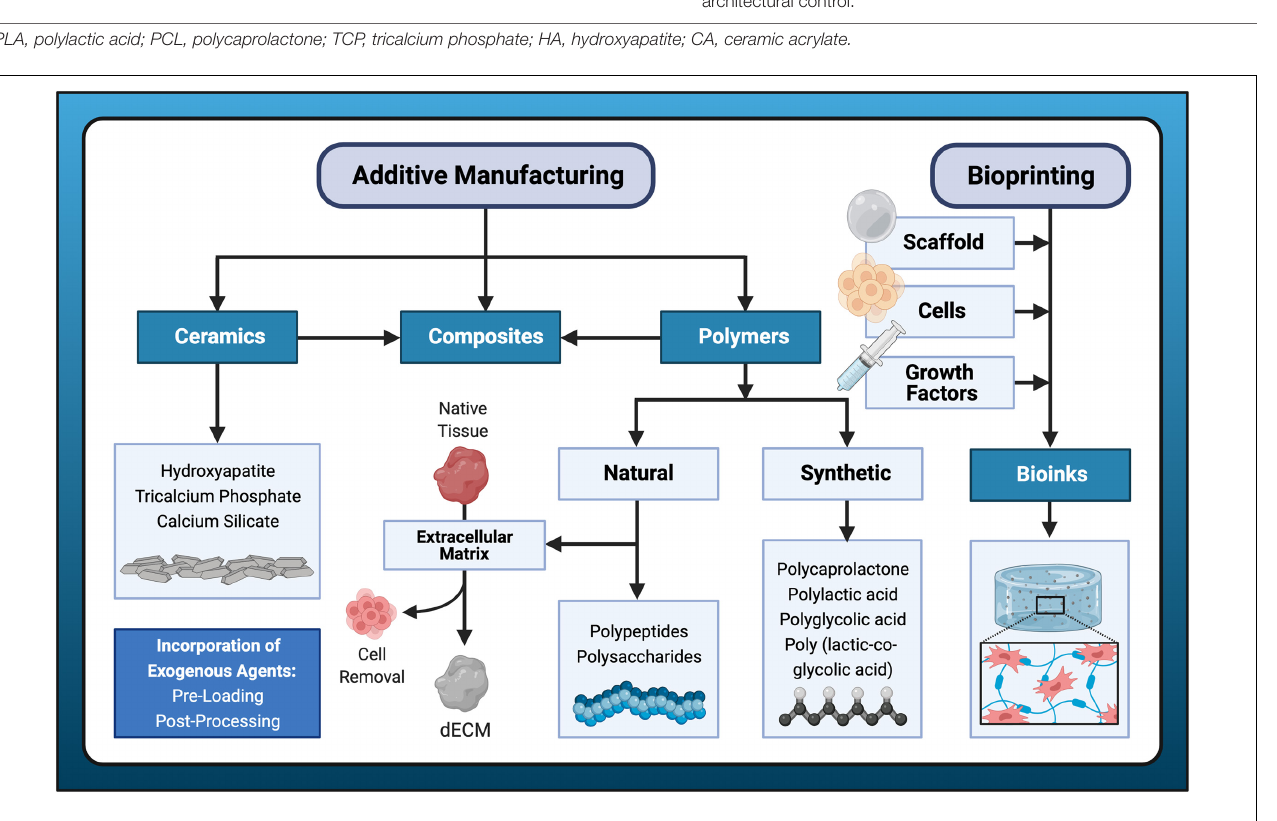
FIGURE 5 | Biomaterials for bone scaffold fabrication. A variety of candidate materials are available for scaffold fabrication using additive manufacturing or bioprinting processes. Additive manufacturing typically employs polymers, to which ceramic materials may be added to form composites. Bioprinting incorporates all three elements of the tissue engineering triad: cells, scaffold (hydrogel), and growth factors. Exogenous agents are often incorporated either with pre-loading or post-processing